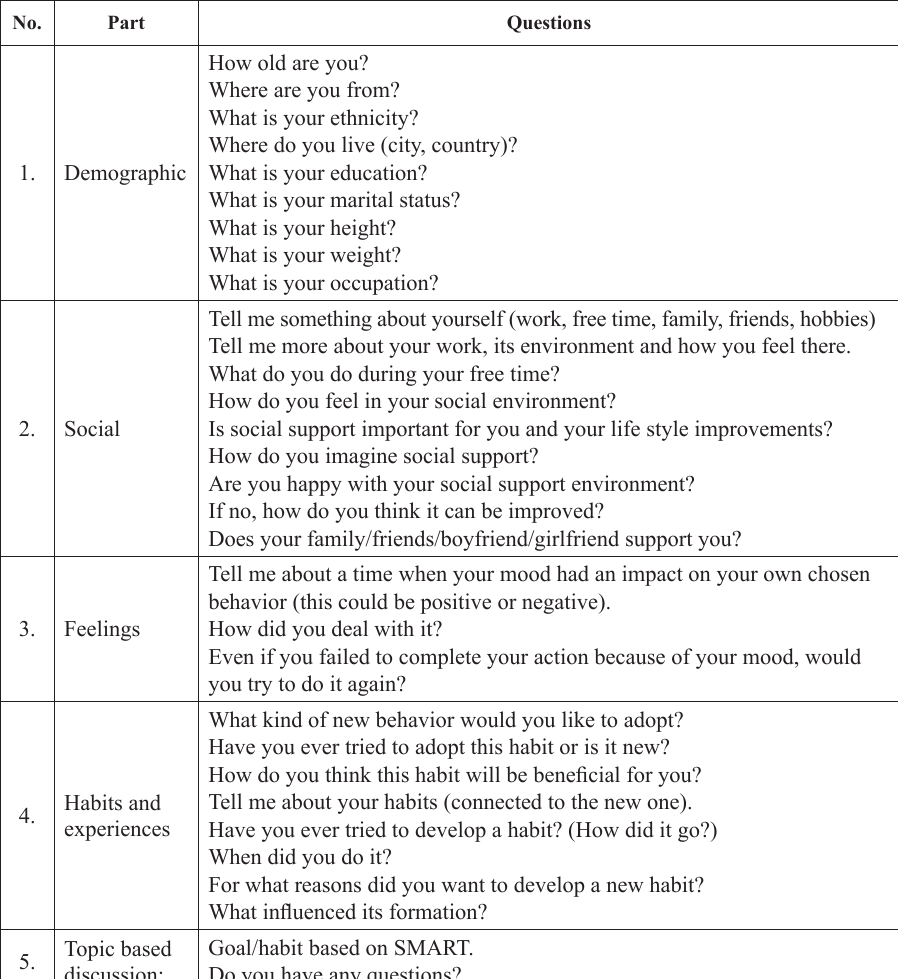
Table 2. Interview questions (Modified by Sharman & colleagues,